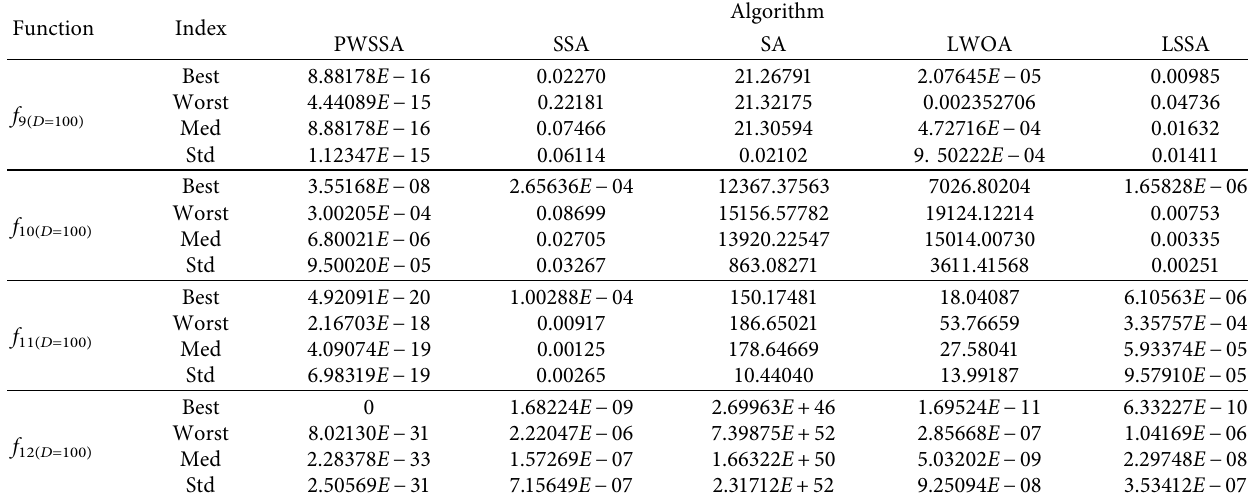
Table 3: Comparison of testing results for functions ( D � 100).